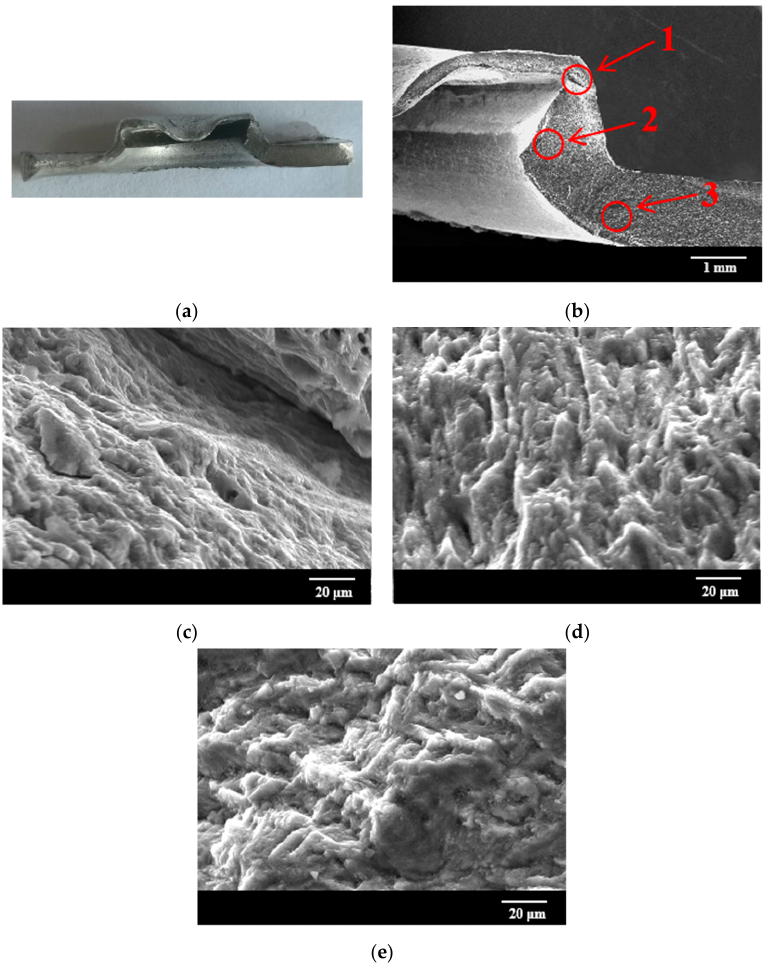
Figure 11. Fatigue fracture micromorphology of uncorroded joints: ( a ) macroscopic morphology; ( b ) microscopic morphology; ( c ) 800× magnification of area 1; ( d ) 800× magnification of area 2; ( e ) 800× magnification of area 3.